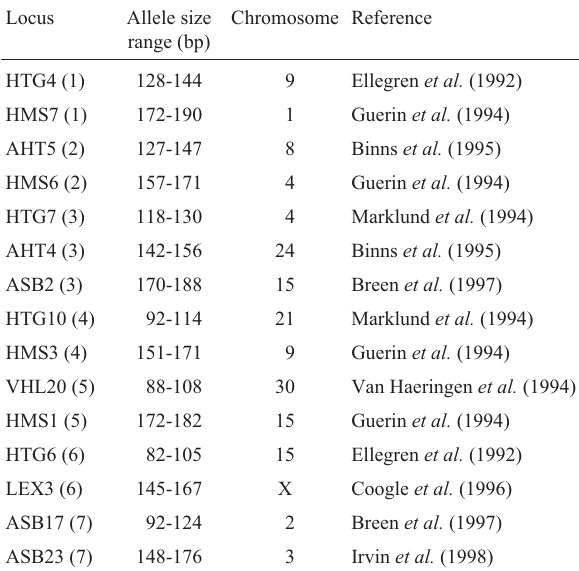
Table 1 - The fifteen ISAG panel markers used in the study of equines of the Marajoara and Puruca breeds. The numbers in brackets indicate the loci analyzed together in muliplex amplification.